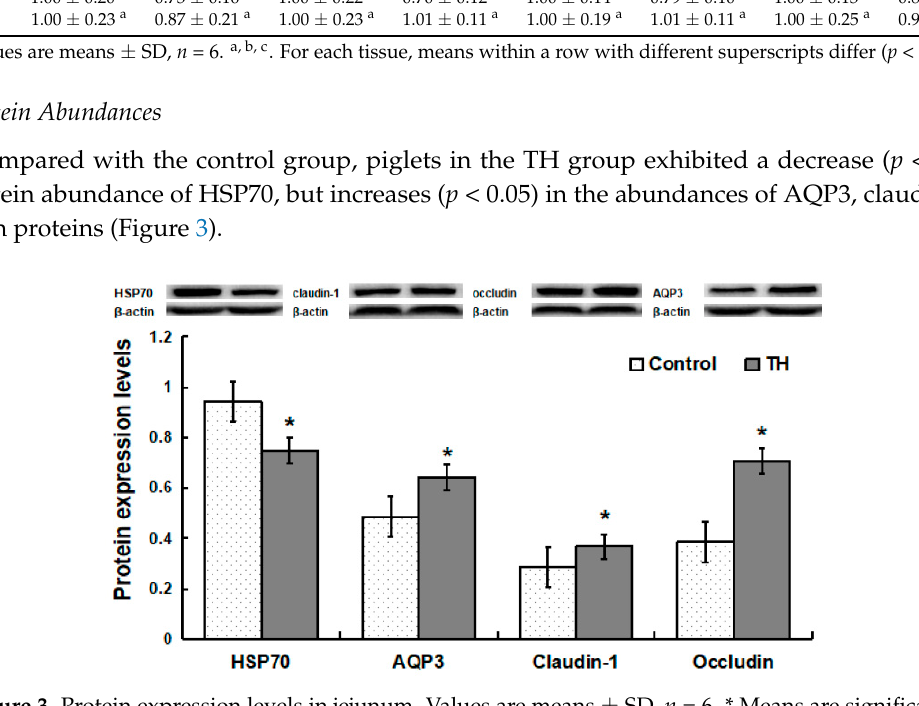
Figure 3. Protein expression levels in jejunum. Values are means ± SD, n = 6. * Means are significantly different from the control group ( p < 0.05).